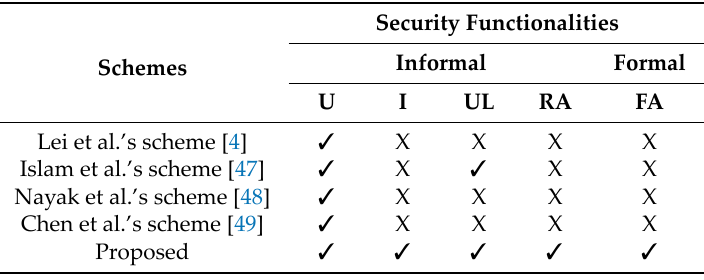
Table 4. Comparison with relevant existing schemes. Legend: U: unforgeability, I: integrity, UL: unlinkability, RA: replay a(cid:308)ack, FA: formal analysis; symbols: ✓ : satisfies the security functionality, X: does not satisfy the security functionality.